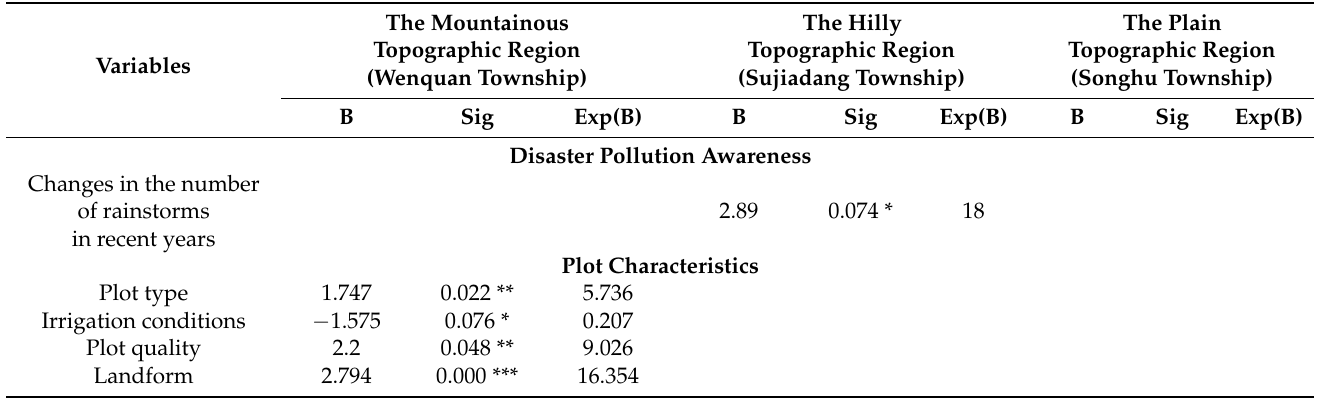
Table 10. Subsample results of part-time households in three topographic